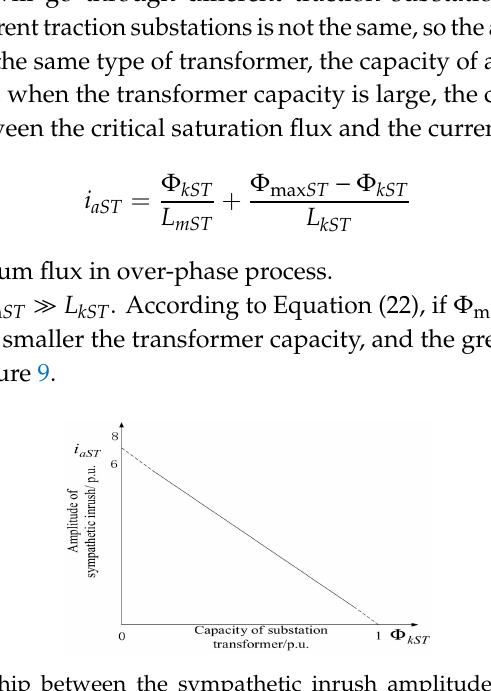
Figure 9. The relationship between the sympathetic inrush amplitude and the capacity of the traction